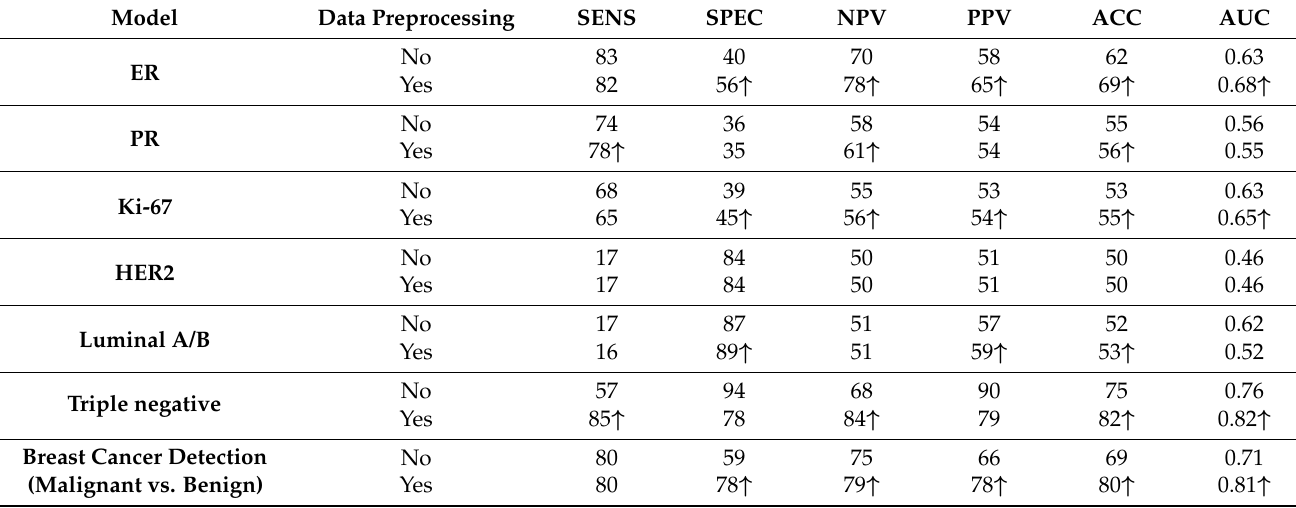
Table 2. Monte Carlo cross-validation performance of all ensemble predictive models with and without data preparation. Confusion matrix values are expressed in percentages (%). AUC is expressed in ratio. Model Data Preprocessing